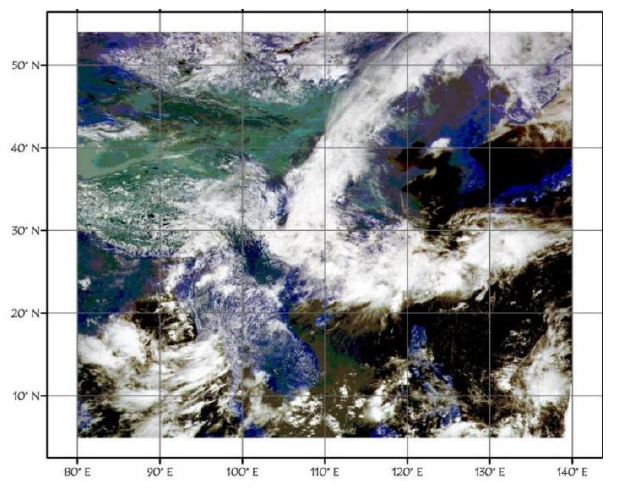
Figure 1. Location of the study